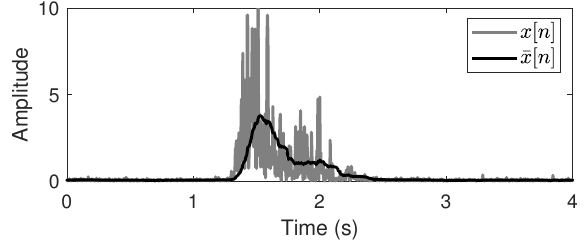
Figure 3. Mean absolute value (MAV) of EMG (Black solid line represents MAV ( ¯ x 1 [ n ] ) of